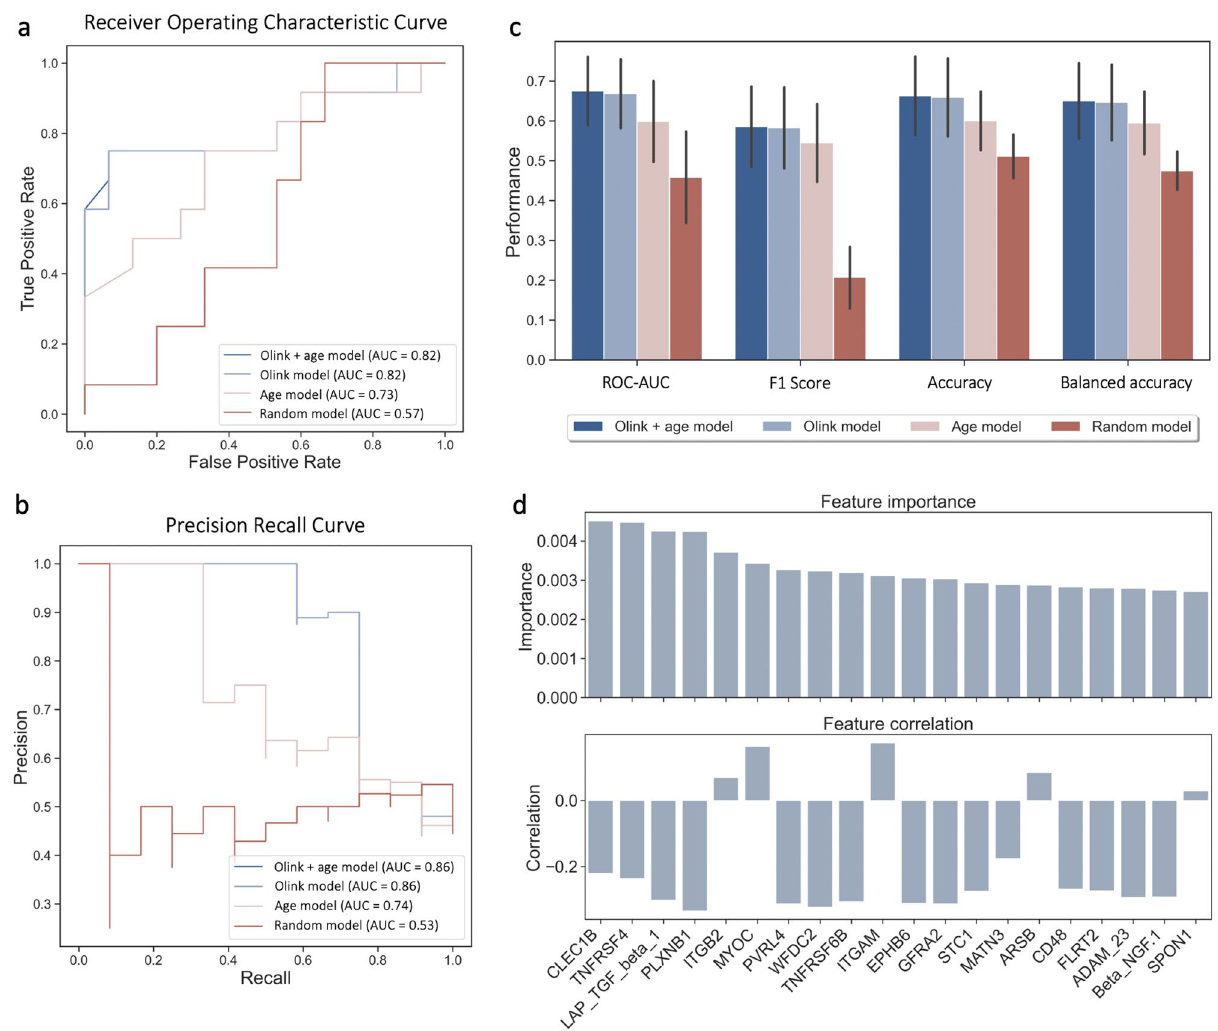
Figure 2. Performance evaluation of different RF classifiers. Four different RF classifiers were trained and evaluated on the independent test set. The Olink + age model was trained on all protein measurements and age; The Olink model is trained on 810 protein measurements. The age model is only trained on age; the Random model is trained on 810 protein measurements with shuffled labels. Four models were evaluated on different metrics: ROC–AUC, F1 score (F1), accuracy (ACC), and balanced accuracy (BACC). ( a ) Receiver operating characteristic and ( b ) precision-recall (PR) curves show the performance of the RF classifiers. The ROC–AUC and PR-AUC of the models using all the protein expression values achieve the highest values of 0.82 ad 0.86 respectively. ( c ) Different evaluation metrics for four models. Stratified train and test split were performed on 10 different random seeds. ( d ) Bar plot on top of the graph show top 20 most important features for predicting the rate of decline based on the Olink model. The bar plot below shows the correlation with the progression. Most of the biomarkers are negatively correlated, thus the lower abundance of these proteins in the CSF is associated with the faster decline in the MMSE trajectory. Protein relative abundance distributions of all selected biomarkers are shown in Fig. S1. The feature importance and correlation analysis for the Olink + age model are displayed in Fig.